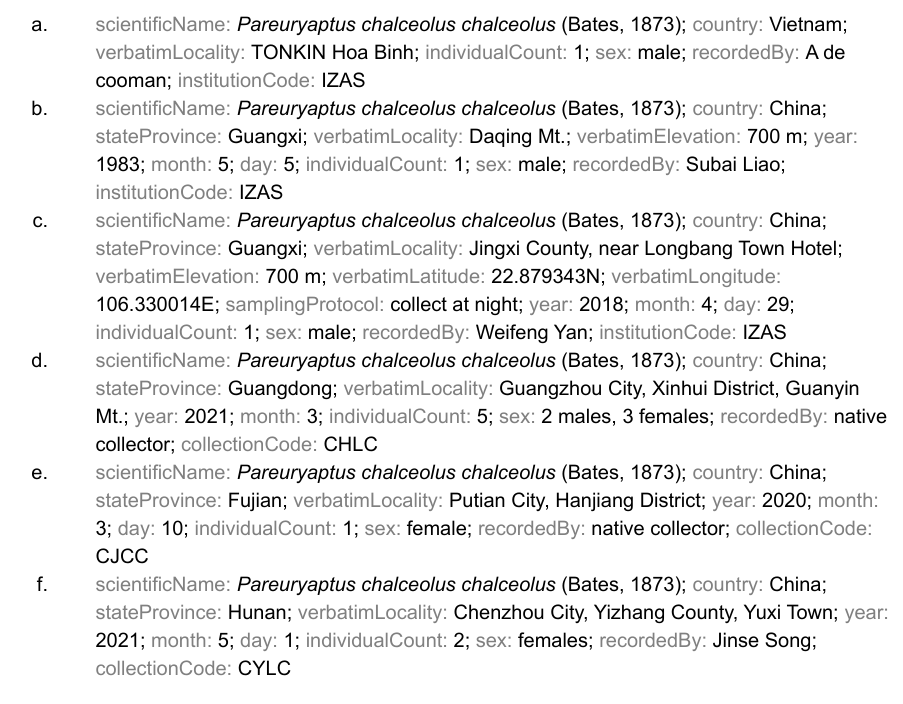
Habitus: Fig. 1e. Male genitalia: Fig. 2e, f. Maxillary palpus: Fig. 3e. Pronotum: Fig. 4e, f. Body length = 11.9-14.5 mm. Dorsal surface black. Terminal maxillary palpimere elongated and ovate, much longer and wider than penultimate one. Pronotum black, widely rounded (pronotum width / pronotum length = 1.33–1.43), widest a little behind anterior third; pronotum densely punctate between basal foveae; lateral margins hardly sinuate in front of posterior angles; posterior angles